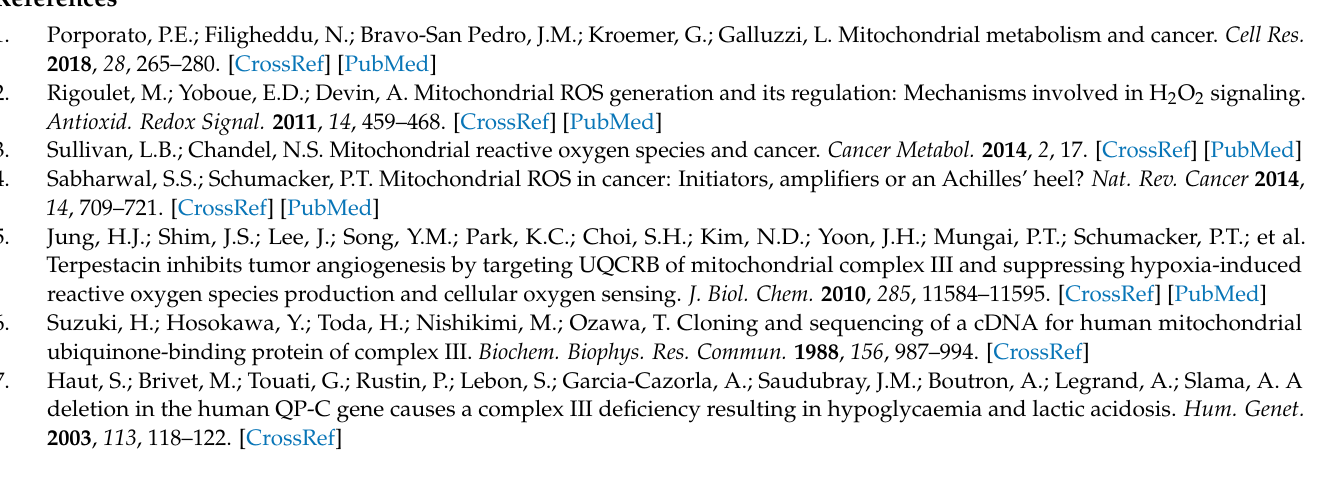
lation; Figure S2: A1938 suppressed autophagy and lysosomal activity in HCT116 cells; Figure S3: The UQCRB inhibitor A1938 attenuated HCT116 xenograft tumor growth. Figure S4: Autophagy marker protein level in the presence or absence of serum. Figure S5: Full Western blot images. File S1: Supplementary Materials and